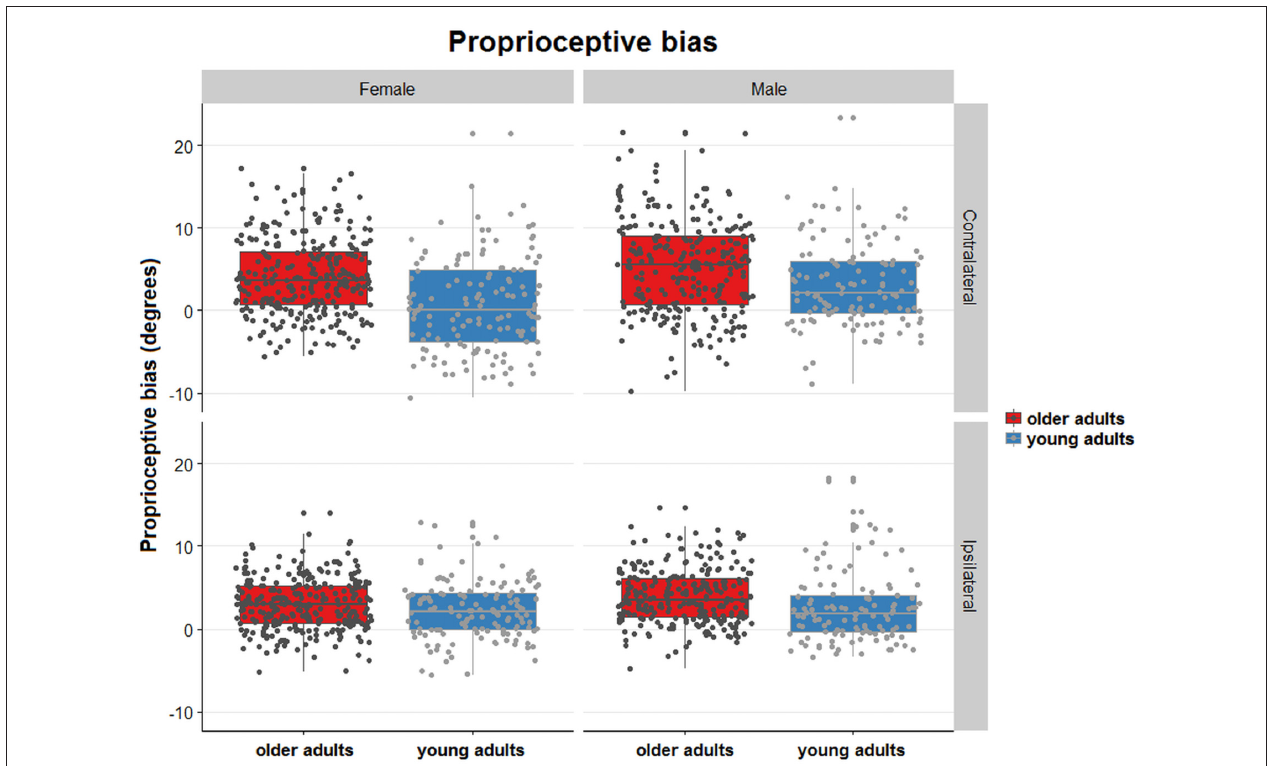
FIGURE 4 | Distribution plots showing proprioceptive signed bias of all trials for contralateral and ipsilateral matching in young and older females and males. Proprioceptive bias for both joint position matching tasks. Each dot represents a single trial. The dots are randomly jittered to avoid point spatial overlap. The degree of error in proprioceptive bias is represented for each type of task, sex, and age group. The colored boxes represent the mean and standard deviation of the proprioceptive signed bias for the type of task sex and age